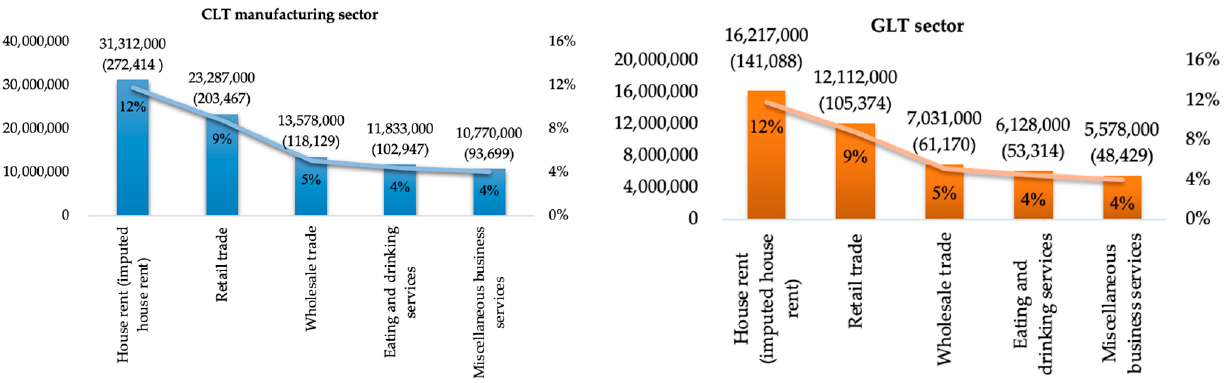
Figure 6. The top five sectors impacted by induced effects (unit: JPY (USD); “%” indicates the percentage of the sector relative to the induced